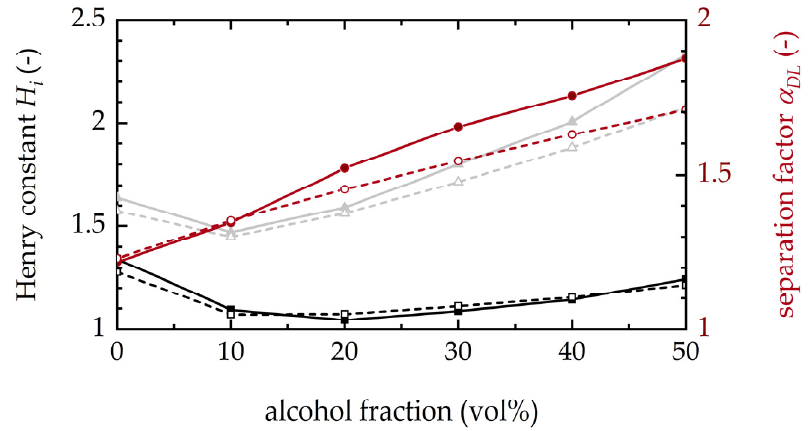
Figure 7. Activity decline of the AAR in an EFBR at room temperature with a constant throughput of 1 mL/min water. The experiment was repeated three times (run 1: 11 days (dark green), run 2: 17 days (medium green); run 3: 59 days (light green)). For the third run, 5 vol% EtOH was added to the eluent from day 32 onwards. The activity was measured with 10 g/L L -Met pumped through the column with a residence time of 0.076 min (1 mL/min, squares) and 0.03 min (2.5 mL/min, diamonds) and the conversions were determined at the column outlet.